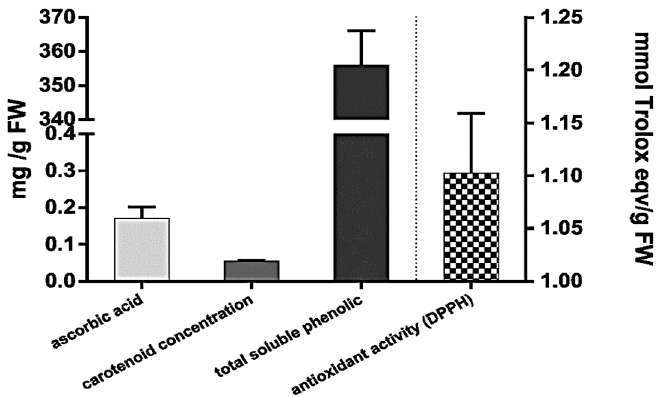
Figure 1. Partial characterization of the antioxidant levels of Aloe vera leaves. Values are given as mean values for triplicates.